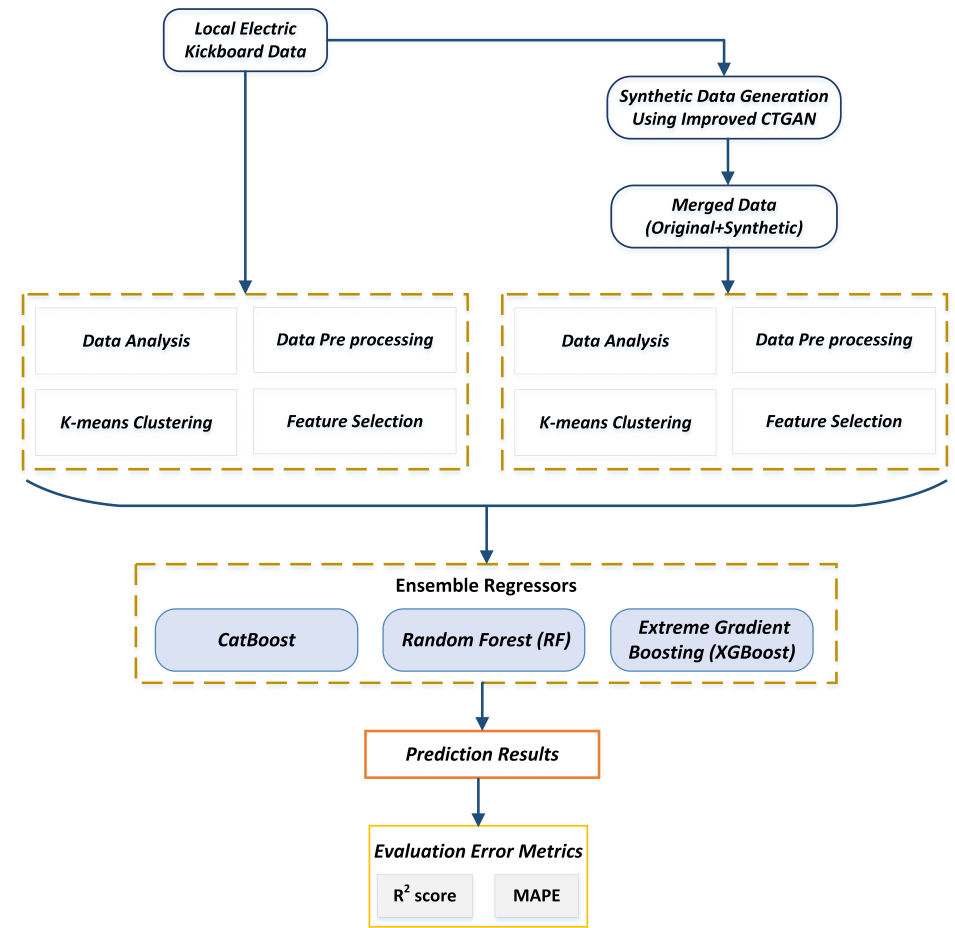
Figure 1. Proposed methodology overview of the